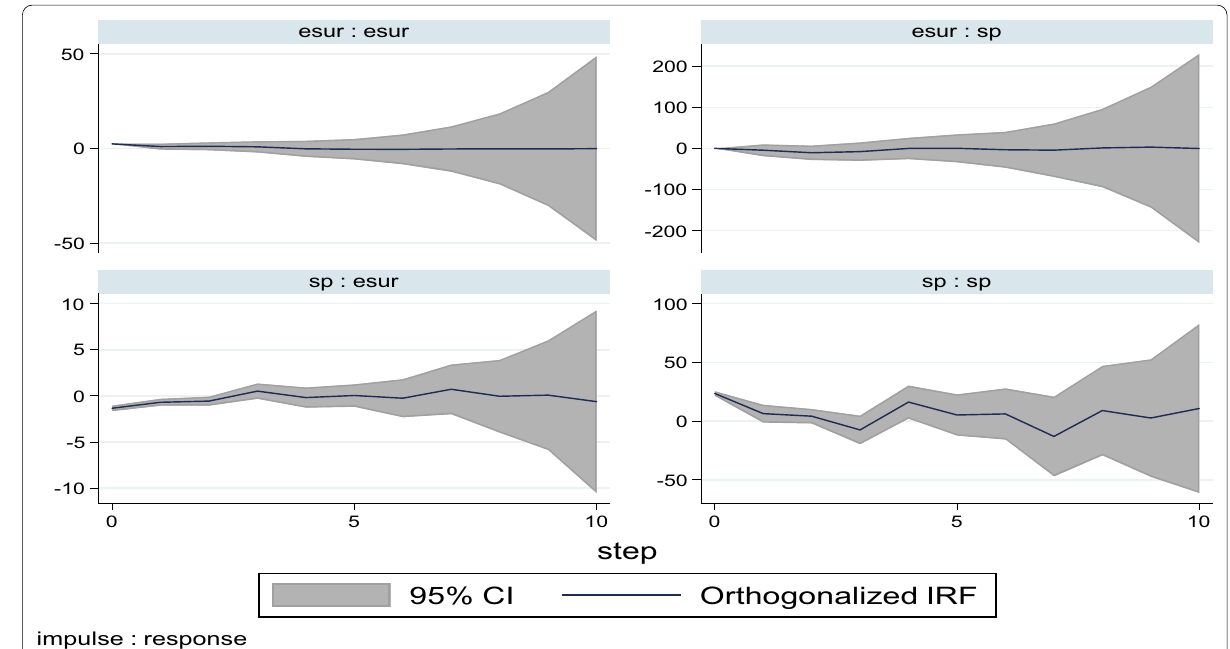
Fig. 1 Impulse response function for ESUR. Source. Researcher’s Compilation